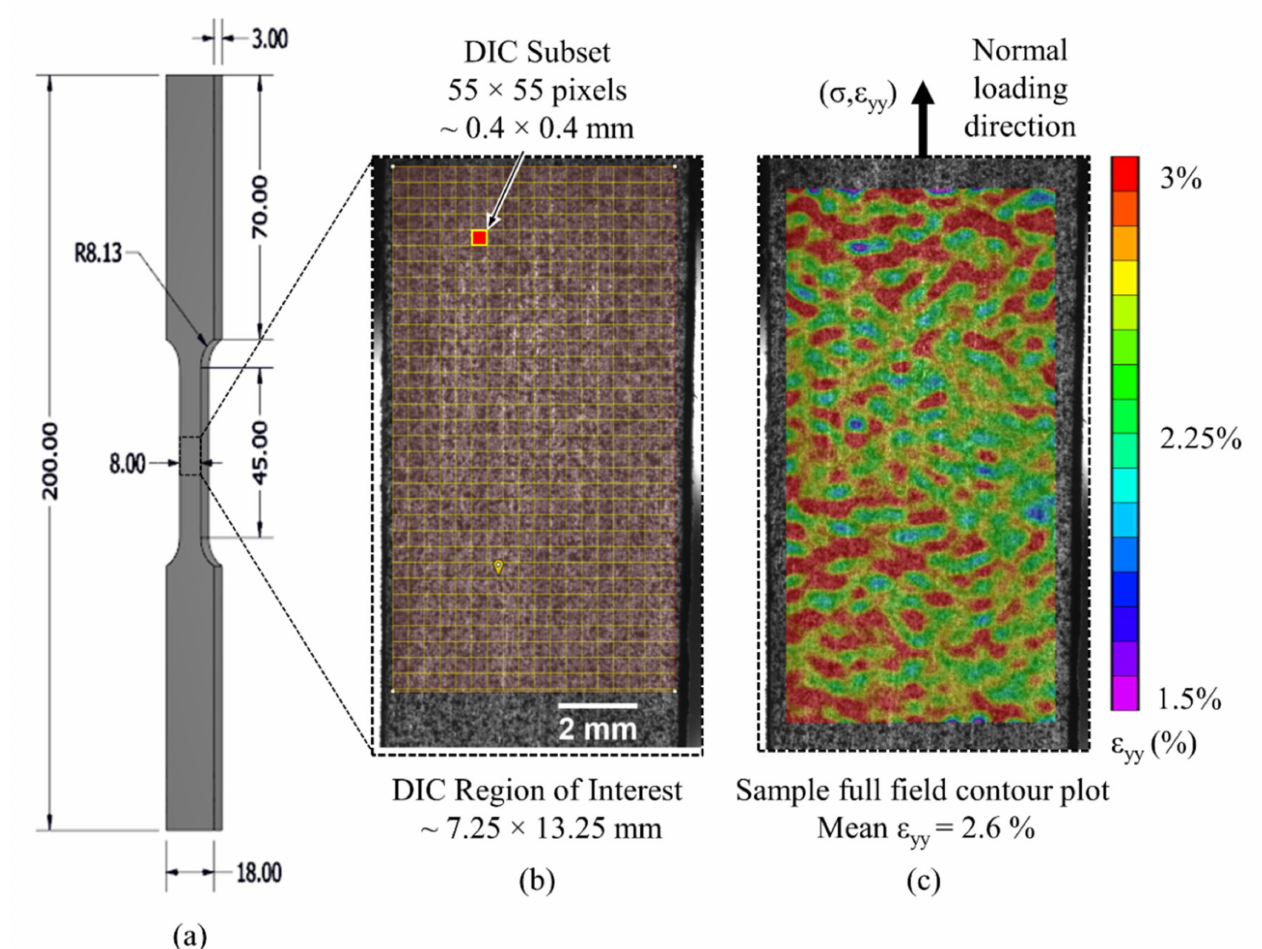
Figure 2. ( a ) Dogbone tensile sample schematic; ( b ) A representative region of interest for DIC correlations; ( c ) Full field contour plot of the normal strain field along the loading direction taken at 2.6% during loading (all dimensions are in